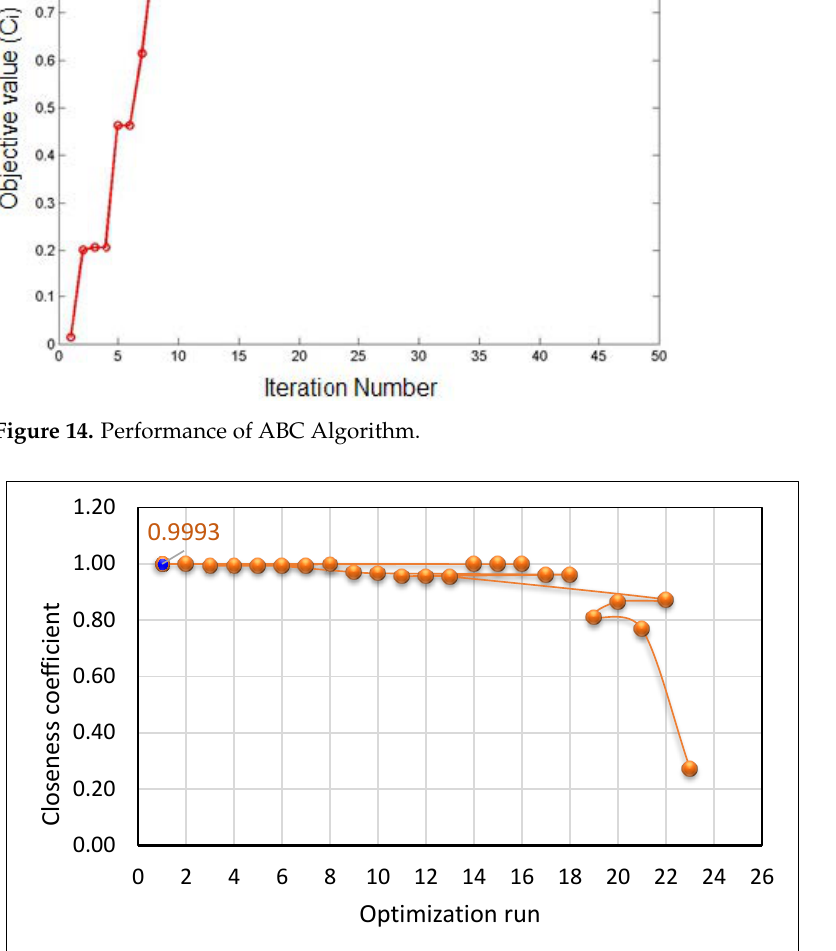
Figure 15. Graphical representation of obtained closeness coefficient values for each optimization run.